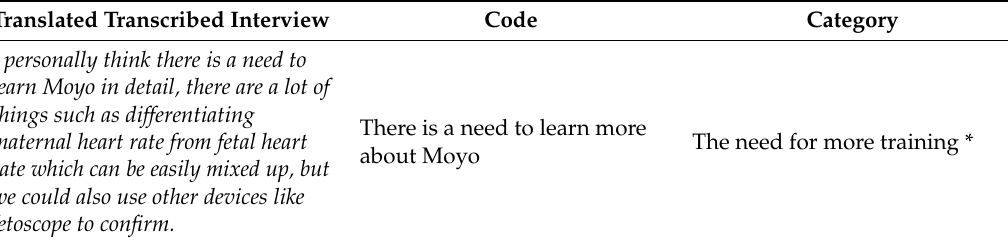
Table 2. Example of the analysis